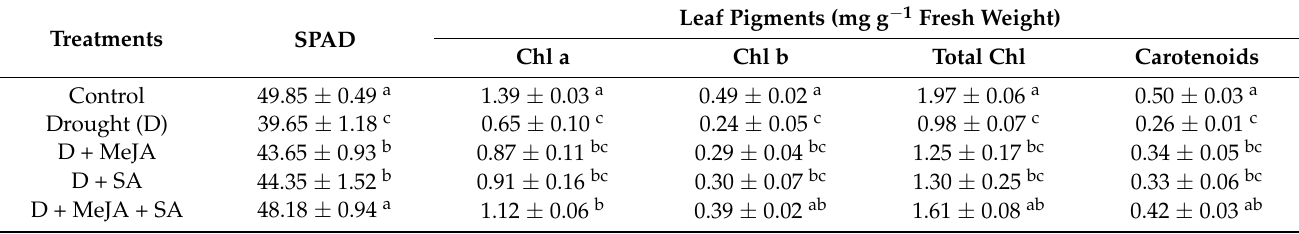
Table 2. Effect of methyl jasmonate (MeJA), salicylic acid (SA), and their combination on SPAD value and leaf pigment contents of French bean plants under drought